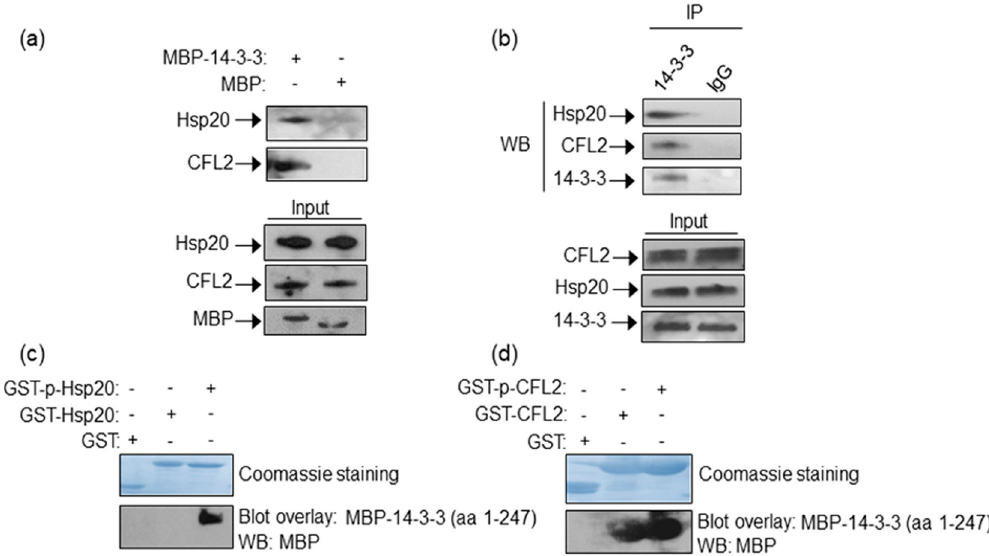
Figure 1. Identification of Hsp20/14-3-3 and 14-3-3/CFL2 protein complexes in cardiac muscle. ( a ) MBP-14-3-3 pull down assays determine its interactions with Hsp20 and CFL2 in cardiac homogenates. ( b ) Immunoprecipitation assays using 14-3-3 or IgG control antibodies confirm the association of 14-3-3/Hsp20 and 14-3-3/CFL2 endogenously in cardiac muscle extracts. ( c , d ) Coomassie staining showing purified GST-Hsp20 and GST-CFL2 recombinant proteins. Hsp20/14-3-3 and 14-3-3/CFL2 interactions are direct, as shown by blot overlay assays. Specifically, 14-3-3 interacts with ( c ) phosphorylated Hsp20 and ( d ) both phosphorylated and non-phosphorylated CFL2, as determined by two independent experiments. No unspecific binding to MBP has been observed in control experiments (Figure S1).